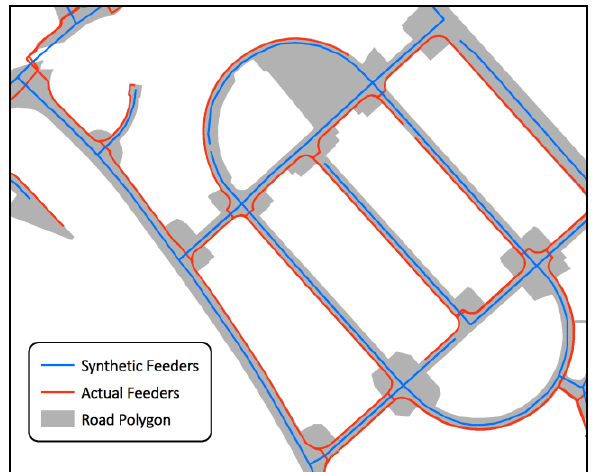
Figure 12. Use of road polygon layer for better validation on the feeders (Contains OS data © Crown copyright and database right 2018).